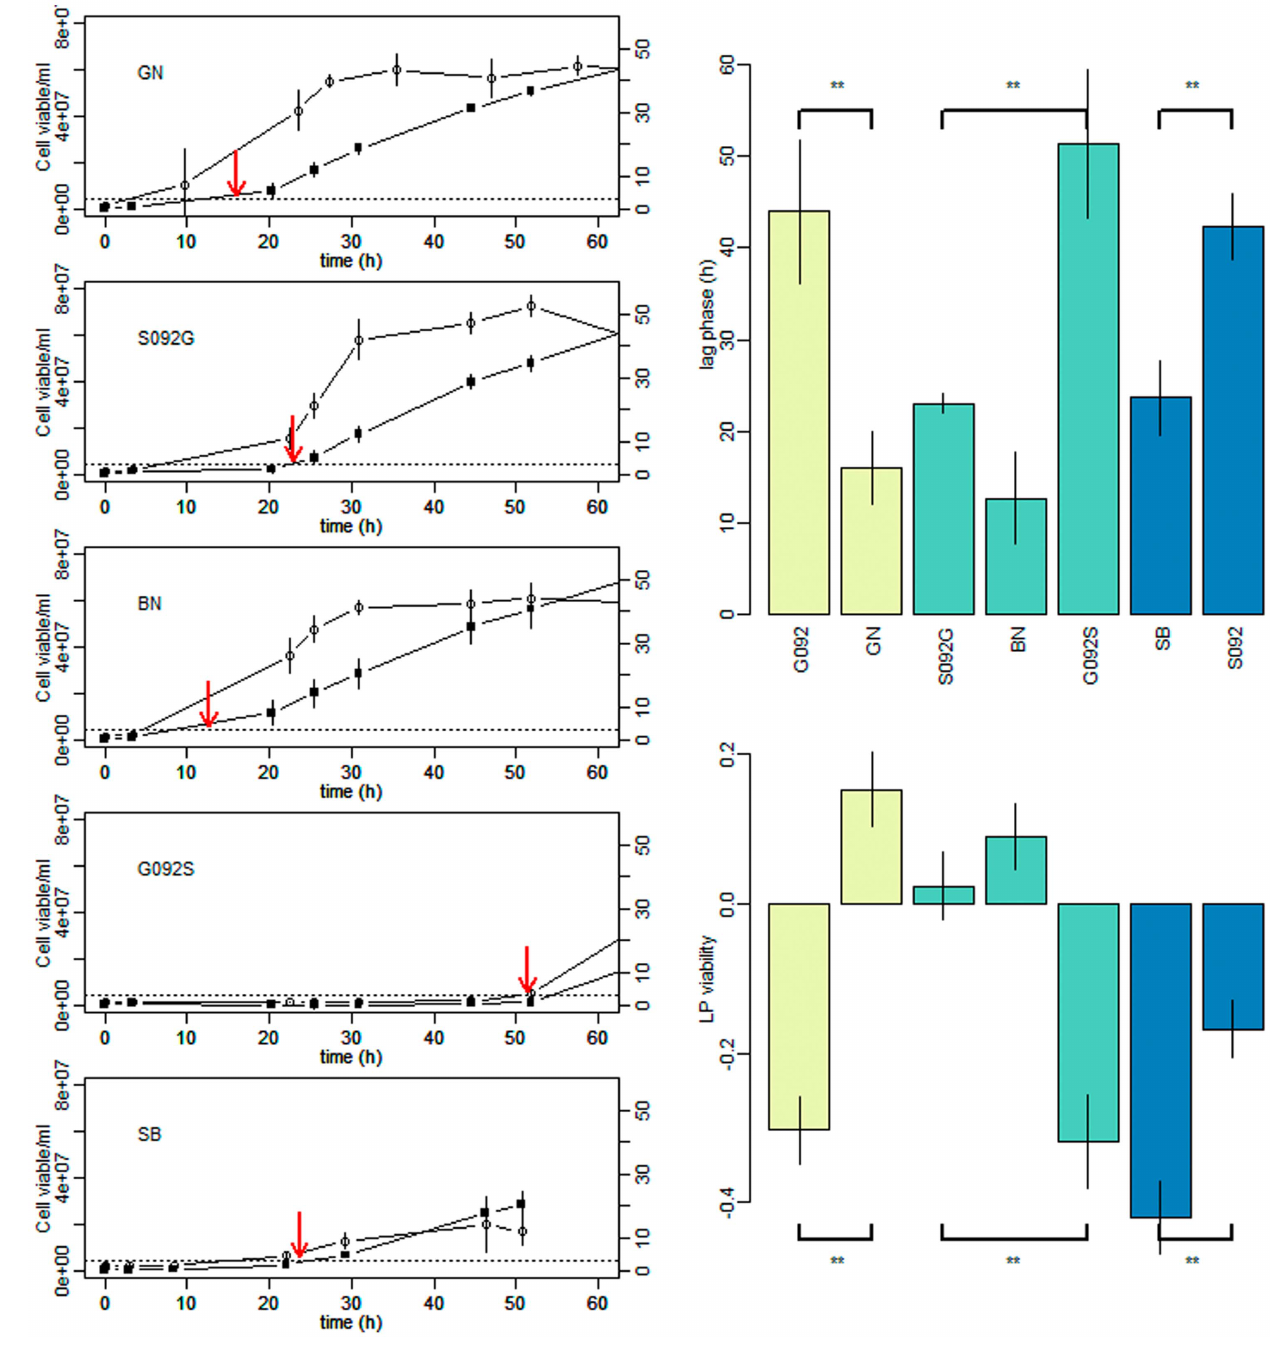
Figure 2. The SSU1 GN allele impact the lag phase in BN background. On the left panel, the time course of viable cell concentration (open circle) and the CO 2 production (black square) during the 60 first hours after yeast inoculation are shown. Data presented are the mean of three independent repetitions with standard error for parental strains (SB and GN), F1 hybrid (BN) as well as hemizygous hybrids (GO92S, S092G) for the gene SSU1 ( YPL092w ). The lag phase time computed is indicated by a red arrow. The bar plots on the right panel represent mean values and standard error measured for 3 independent repetitions for the lag phase (h) and the LP viability. These traits were measured for parental strains (SB and GN), F1 hybrid (BN), the hemizygous hybrids (GO92S, S092G) for the gene SSU1 ( YPL092w ) and the SSU1 double deletion mutant of GN and SB (G092 and S092). Isogenic strains are represented with the same color, GN=light green, BN=green, SB=blue. The statistic difference between isogenic strains was tested using a Wilcoxon test. The significant level is coded **, for p-values , 0.01. 40% of CO 2 released in a synthetic medium. Of the eight strains translocation (F10, Fx10), one has the XV-t-XVI translocation used, four have wild-type copies of chromosome XVI (nt-XVI) (VL3), and the last possesses all the possible forms (F33). As shown (382, A24, XMC30 and OS104), two carry the VIII-t-XVI in Figure 5, the strains carrying translocations have the highest